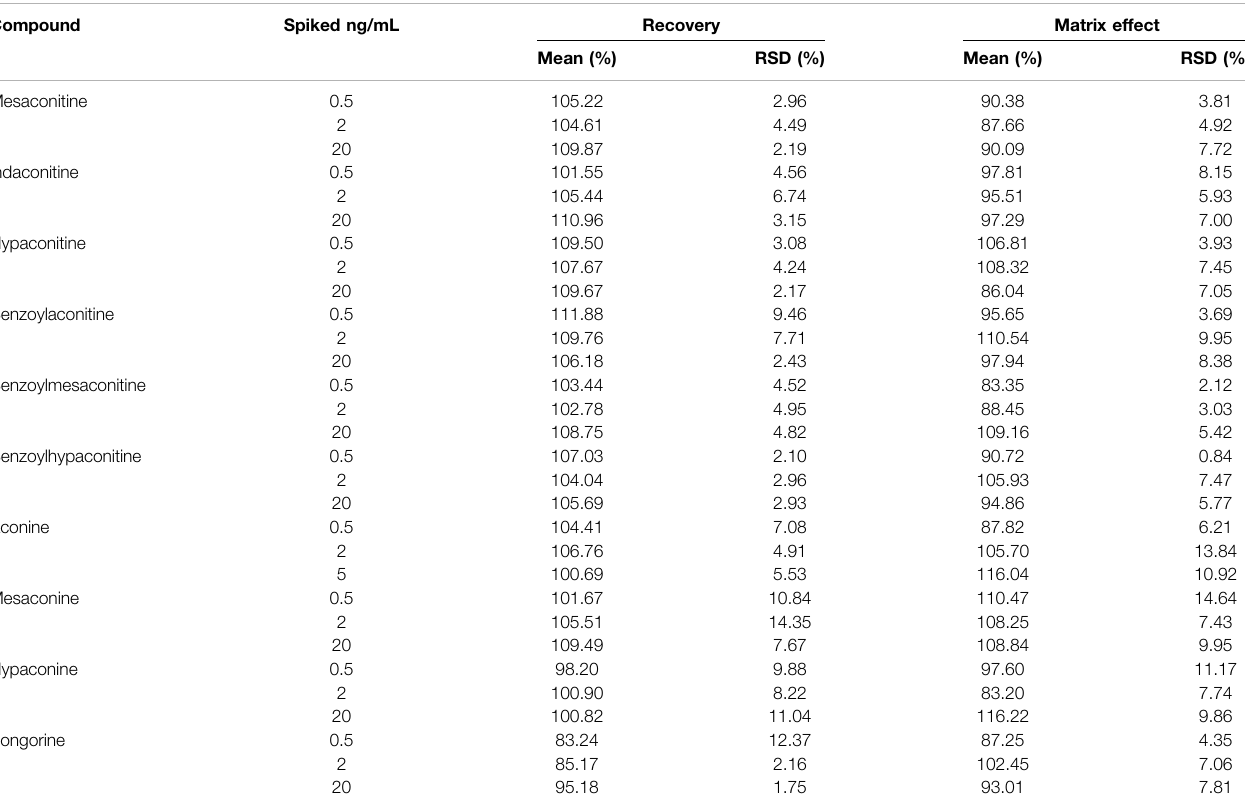
TABLE 5 | Recovery and matrix effect of PK method. Compound Spiked ng/mL